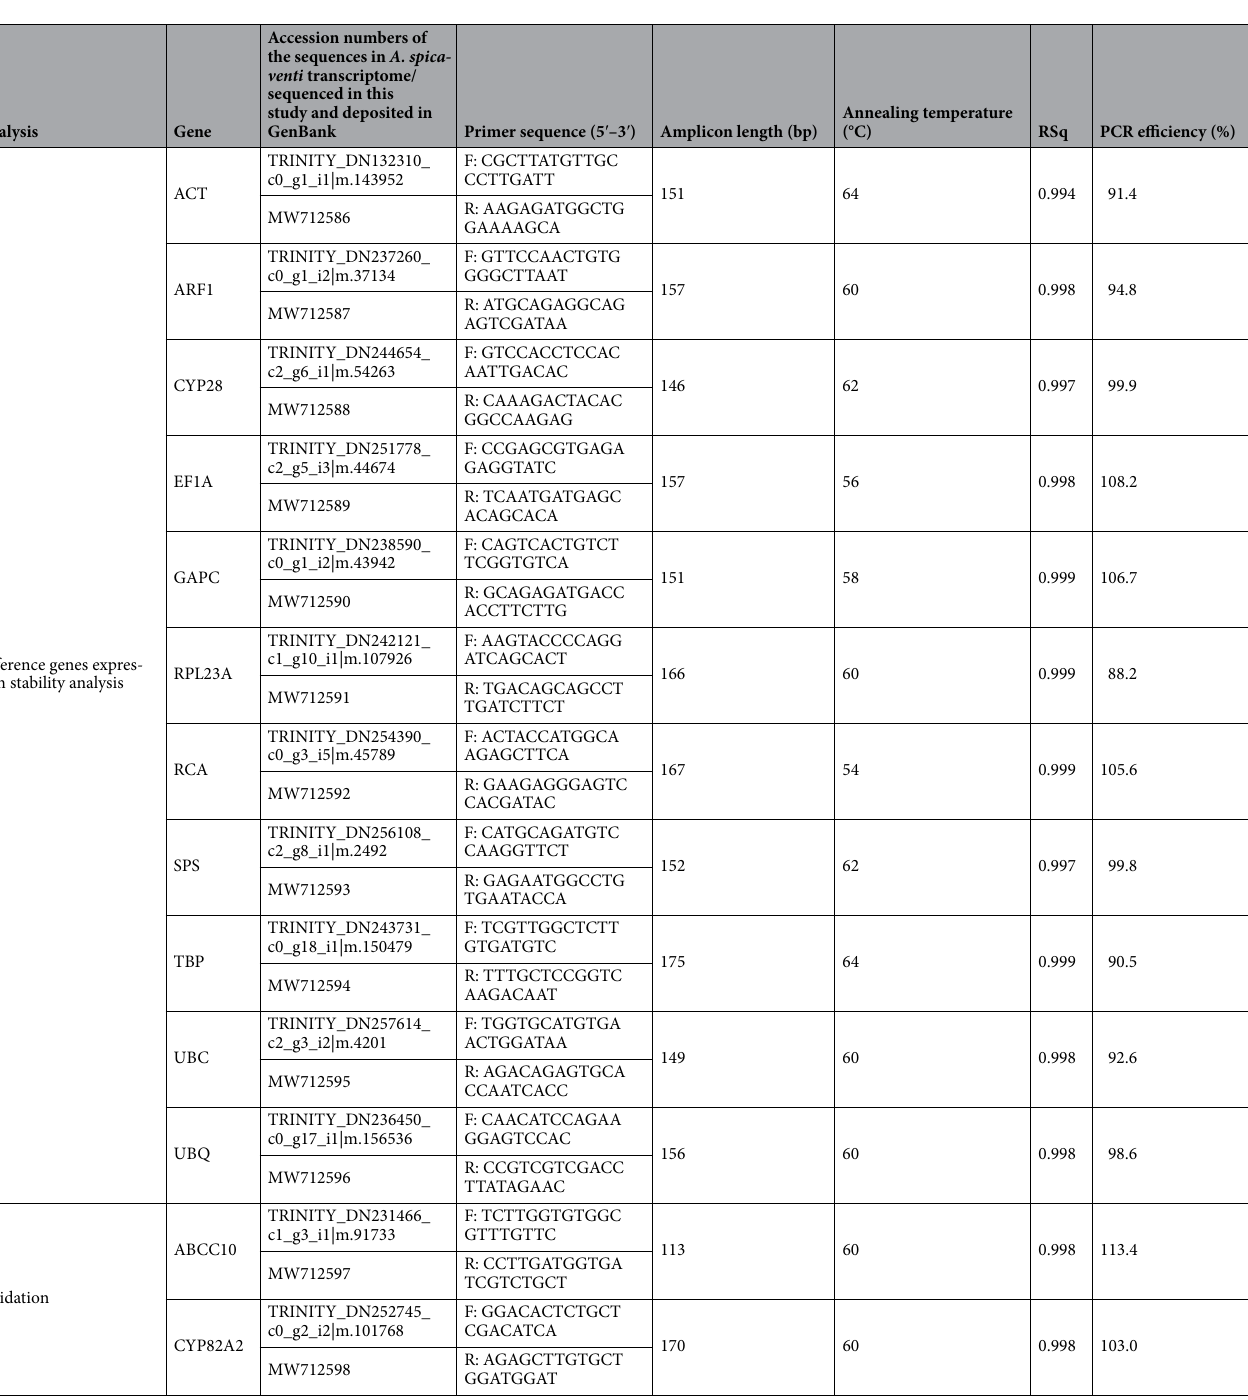
Table 1. Primer sequences for RT ‐ qPCR used in this study. RSq R ‐ squared value for standard